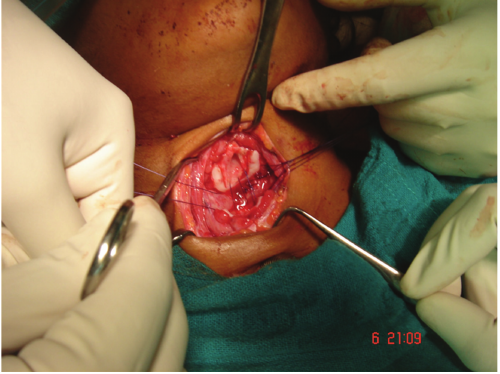
Figure 1: Clinical photograph showing cricotracheal separation.